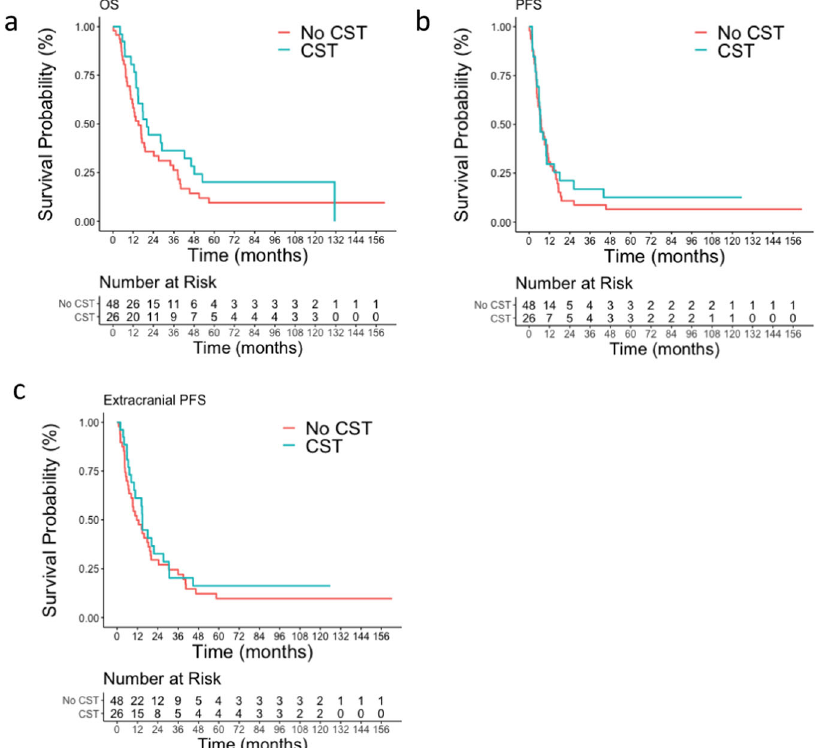
Fig. 2 Survival comparison between patients who had change of systemic therapy (CST) and those who did not (no-CST). a Median OS was 20.1 months among patients who had CST as compared to 15.1 among those who had no-CST (HR = 0.68 [0.40 – 1.16], p = 0.16). b Median PFS was 6.6 months among patients who had CST as compared to 7.1 among those who had no-CST (HR = 0.88 [0.52 – 1.47], p = 0.62). c Extracranial PFS from local management of BM in CST patients (14.9 months; 95% CI 10 – 30.5) compared with no-CST patients (11.6